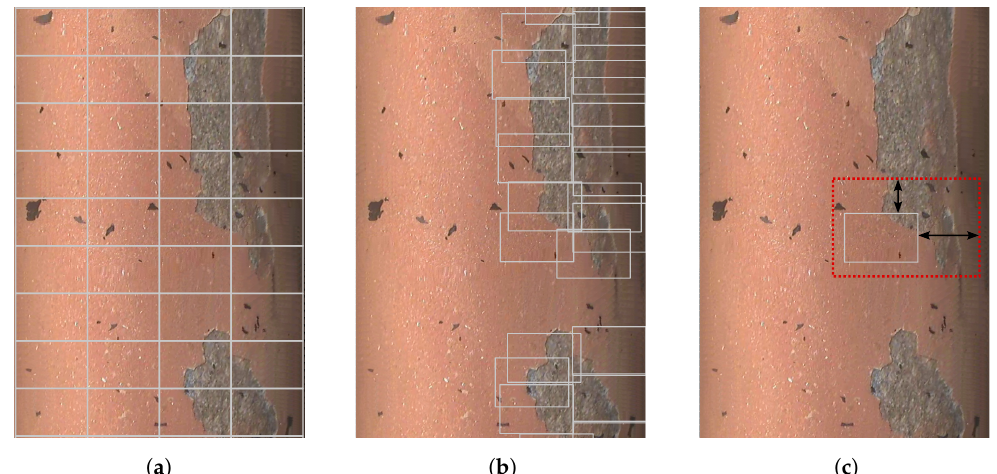
Figure 5. Visualization of the algorithm steps for methods LCO and CM . ( a ) SP result with smaller patches ( LCO patches with a shape of 192 × 128 pixels). ( c ) Selection of the best patch location by shifting, depicted for one patch O i (refer to Figure 4, LCO , green and yellow box). Here, the gray patch was fixed while the red patch was shifted to achieve a low class proportion cost. Thereafter, the red patch was forwarded towards the small-scale segmentation. ( b ) Result of the applied GCO method with LCO patches in the CM algorithm (see Figure 4, CM , blue box). The patches were arranged to achieve a low class proportion cost while covering all edges of the existing binary damage